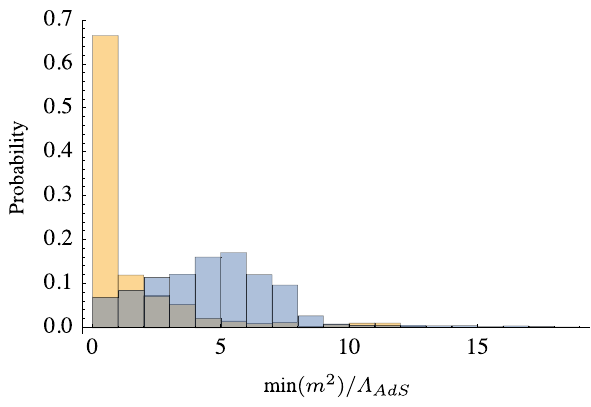
Fig. 10 Histogram of the scale separation between the lightest modu- lus and the corresponding value of the cosmological constant in Planck units min ( m 2 /Λ AdS ) . Yellow bars correspond to hierarchical fluxes while blue bars correspond to non-hierarchical